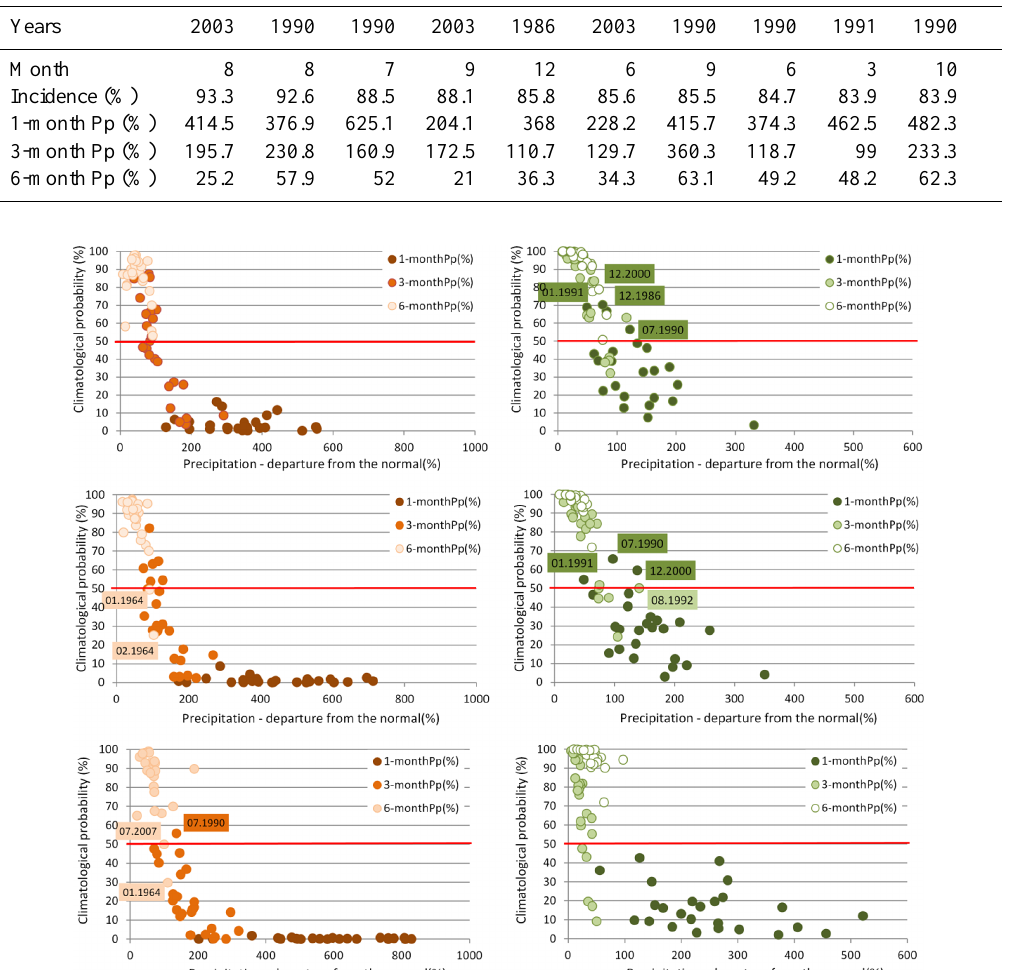
Table 2. Percentage above the normal precipitation needed to end a drought – Pp (%) – in the next 1, 3, and 6 months for the drought events with the highest incidence (% surface from the region)